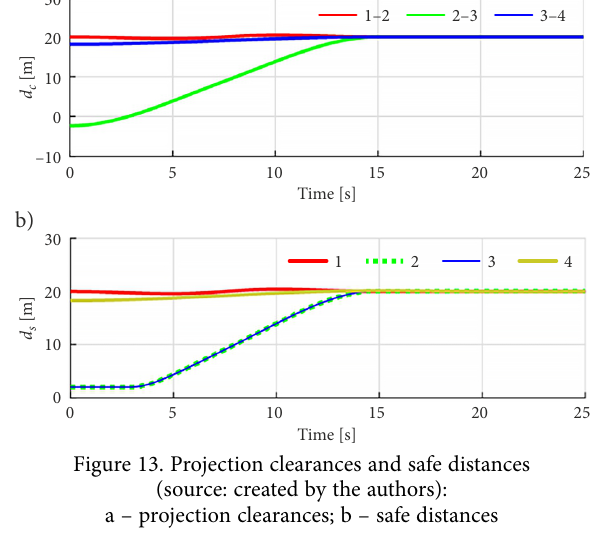
Figure 12. Camera shots of merging operation (source: created by the authors):